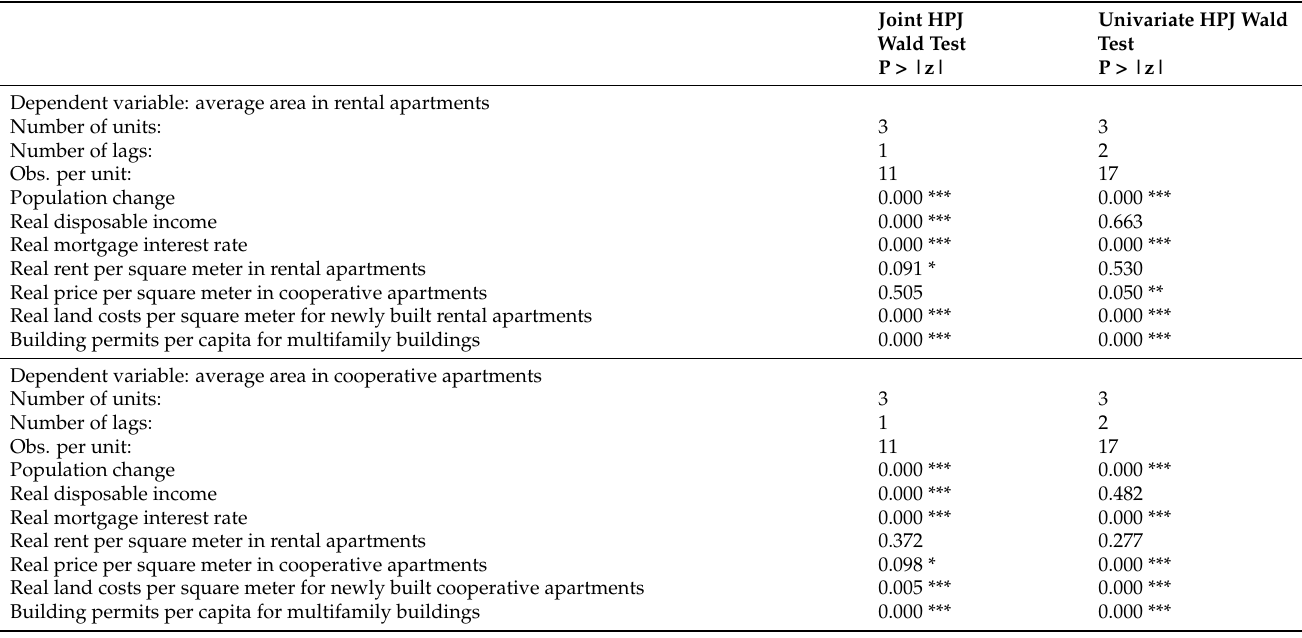
Table 5. Granger non-causality test